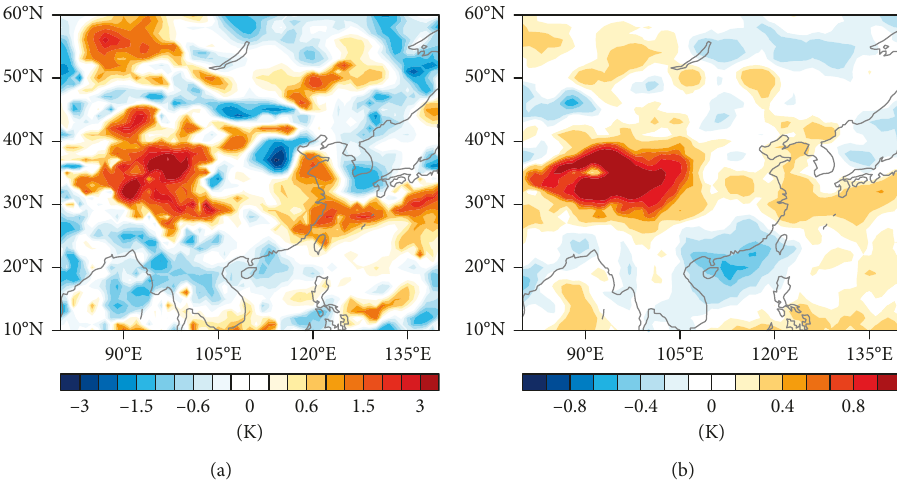
Figure 7: 24 h nonsystematic error of temperature on 500hPa on July 6, 2010 (unit: K): (a) nonsystematic error and (b) nonsystematic error estimated by variational